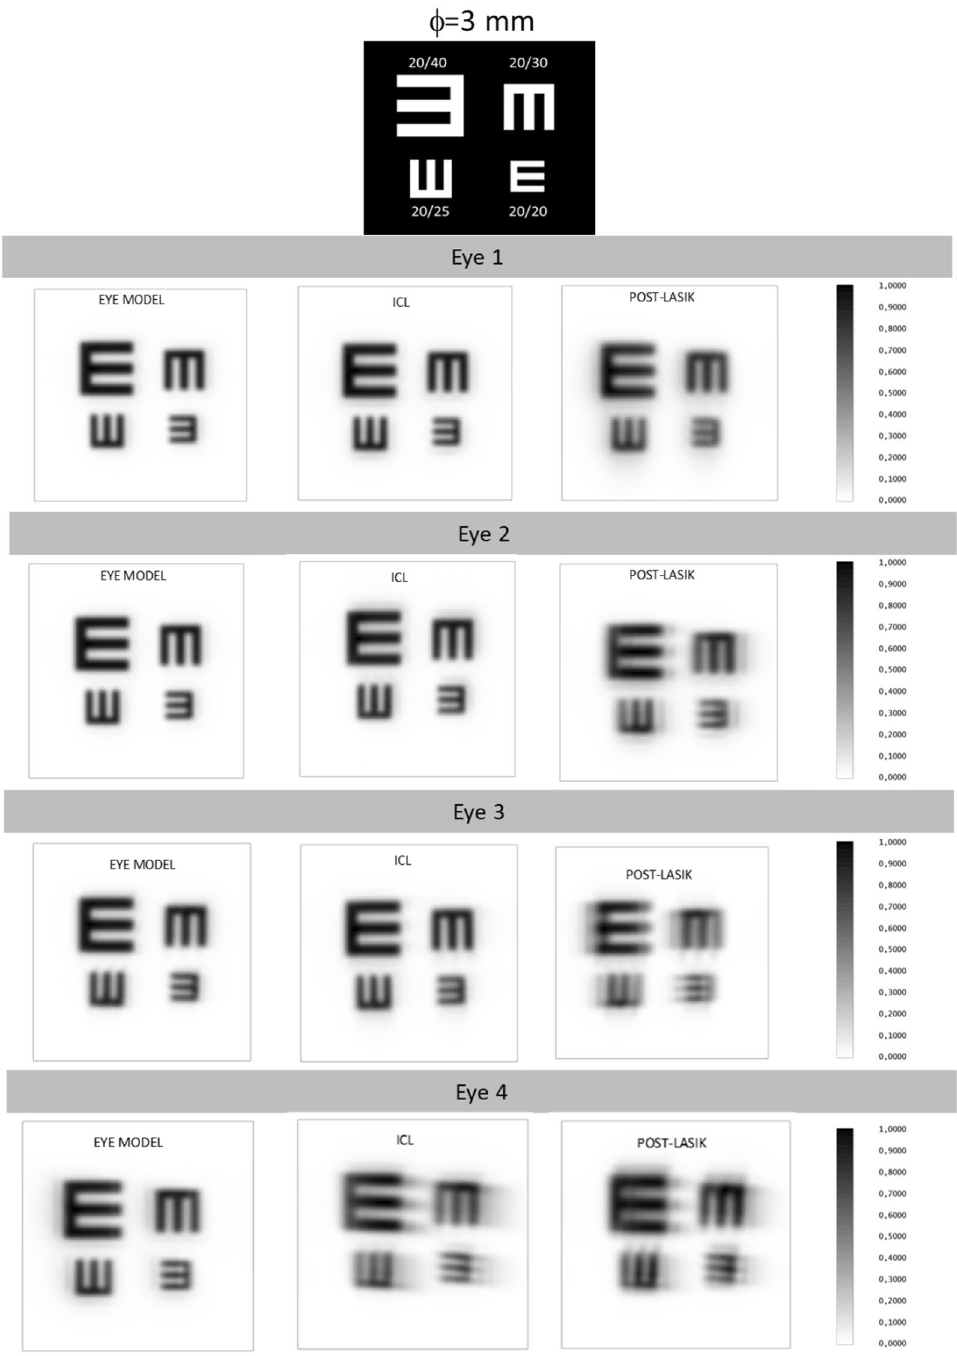
Figure 5. Simulated vision of the optotypes of the three eye models (eye model, ICL model and post-LASIK model) for the pupil size of 3